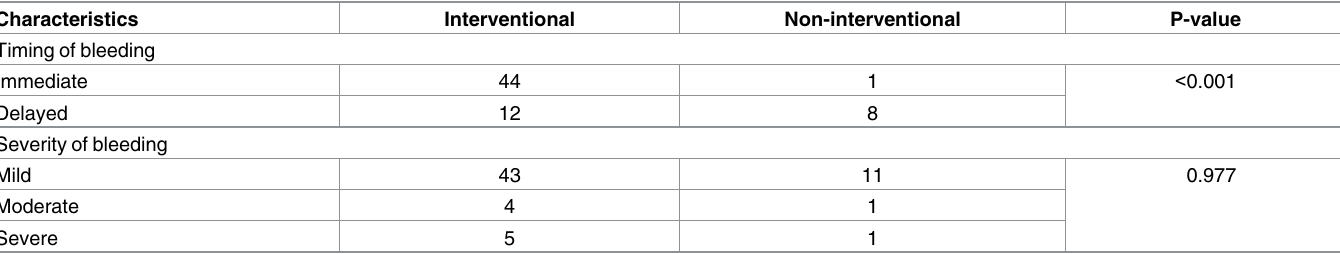
Table 4. Comparison of post-endoscopic sphincterotomy bleeding between endoscopic interventional and non-interventional therapy groups.